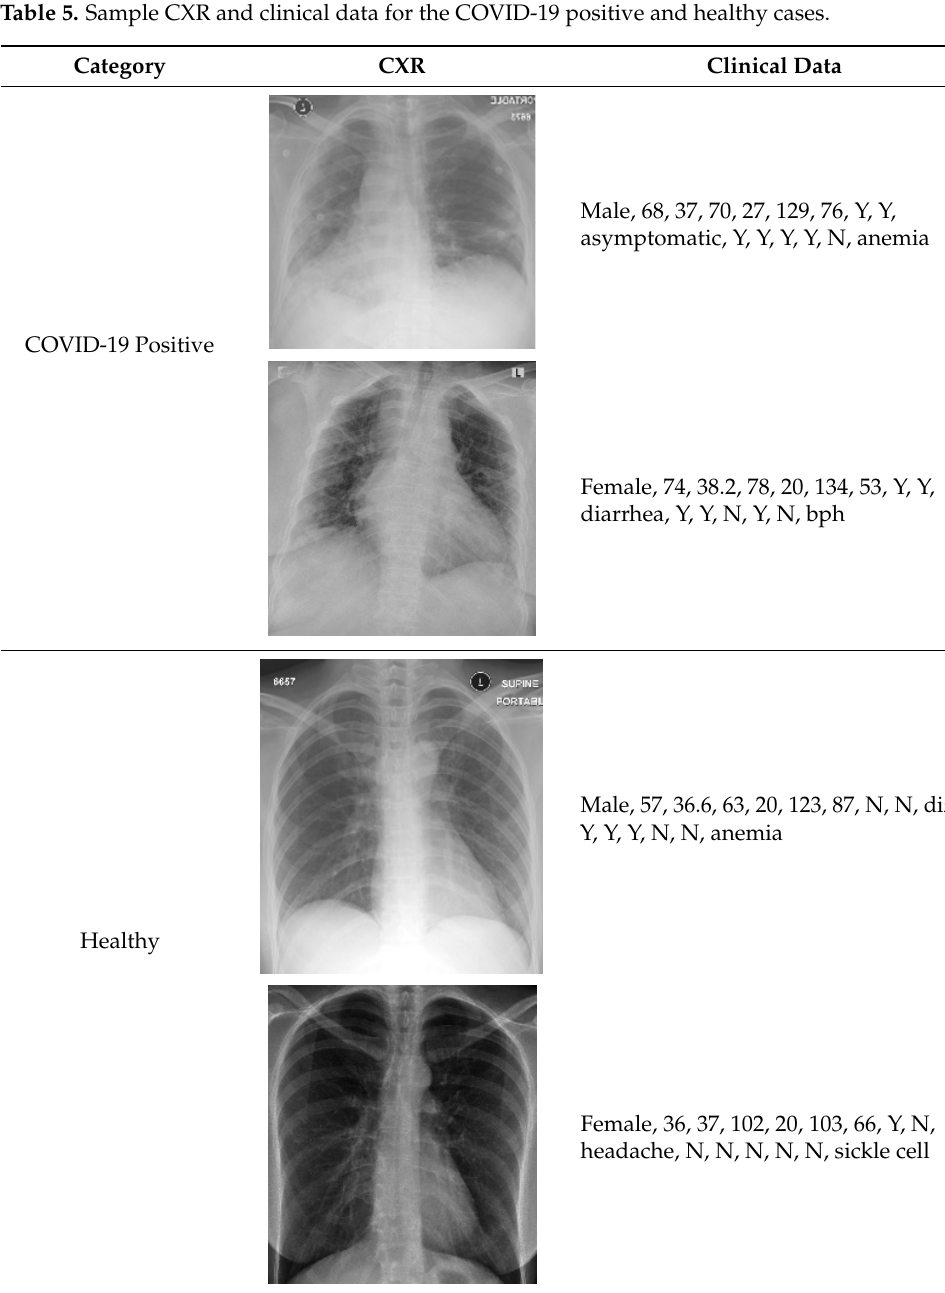
12 of 16 Figure 8. Confusion matrix for case 3 (clinical data and chest X-ray (CXR)). Table 4 above shows that the hybrid approach showed significant improvements in terms of all the performance measures, especially in terms of accuracy with a value of 0.970. Moreover, the high values of precision and recall scores indicate good performance of the model in terms of false positive and false negative rates. The 0.986 value of the recall shows that the model aims to minimize the false-negative rates so that it does not show a high loss of COVID-19 infected cases. Whereas the precision value of 0.978 shows that the model also minimizes the false positive rates, so it does not show a high misclassification of COVID-19 infected cases. Furthermore, since DL models require an immense number of images to achieve acceptable performance, the second case where only images were used showed the worst results due to the shortage of COVID-19 patients’ CXR in the used dataset. Therefore, we believe that combining CXR images with clinical data can be con- sidered a solution for health authorities to diagnose COVID-19 patients in an efficient and quick manner. Furthermore, some of the examples of the COVID-19 positive and the healthy pa-